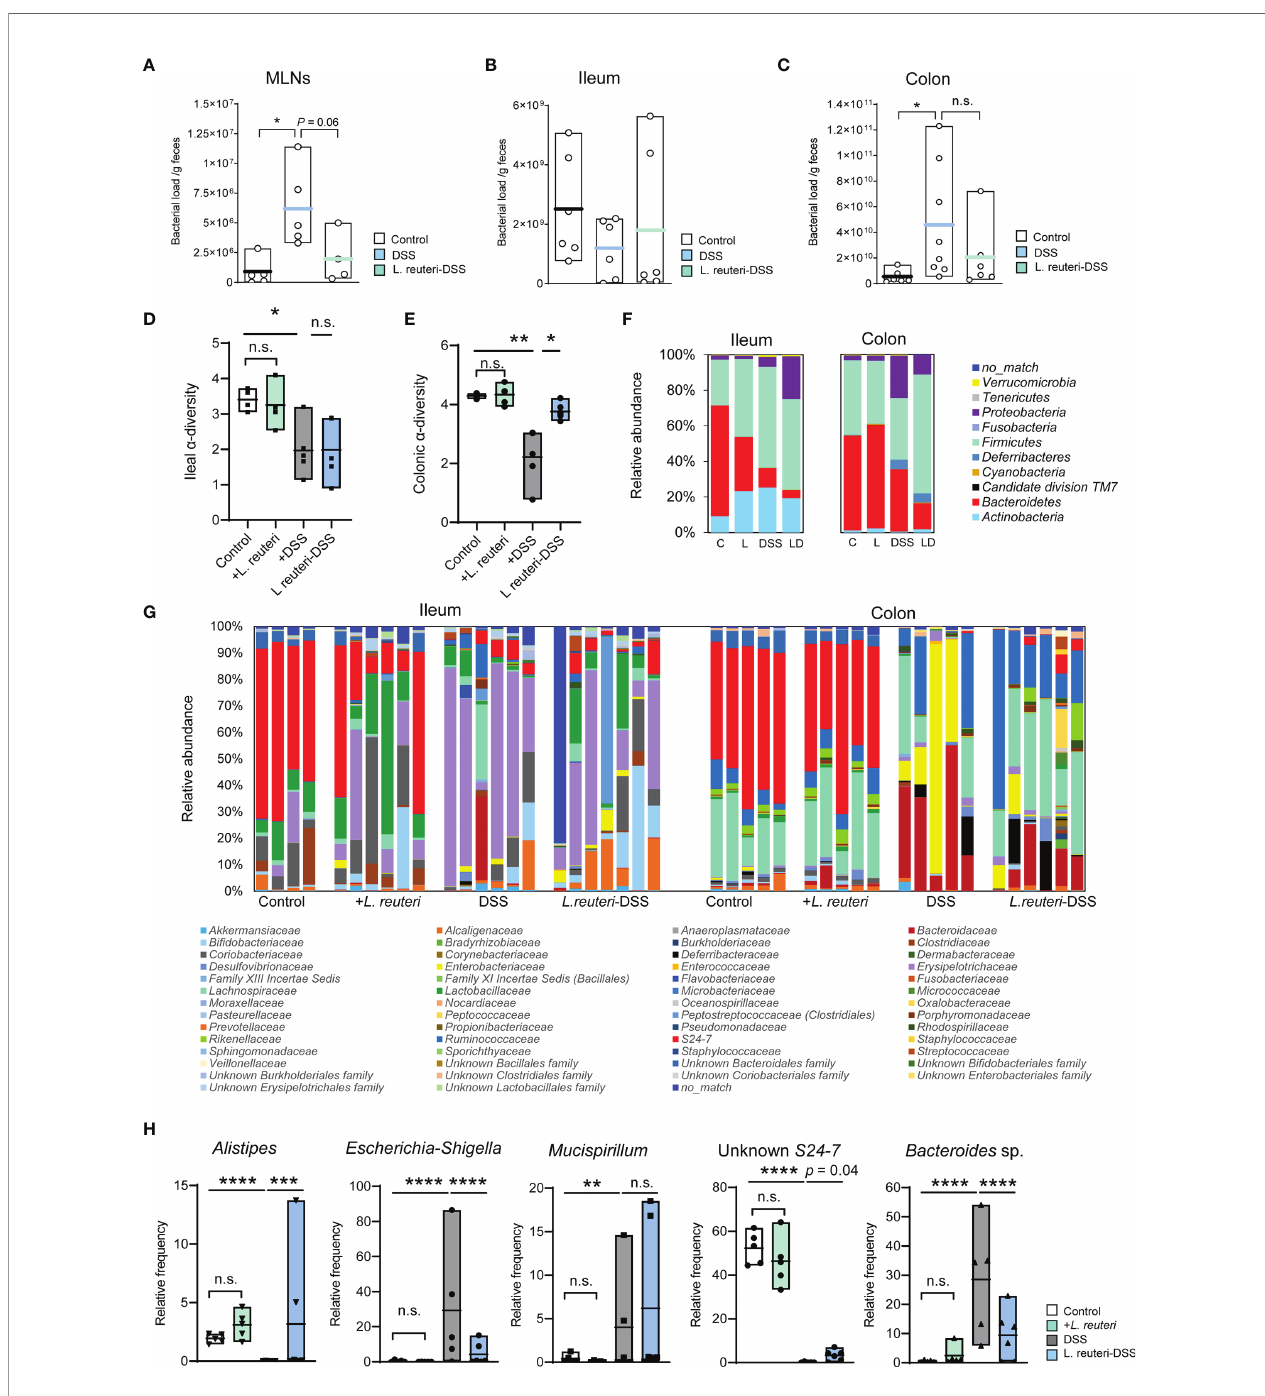
FIGURE 3 | Peroral treatment with L. reuteri reduces gut microbiota dysbiosis in DSS-induced colitis in young mice. (A – C) Microbial loads in MLNs and ileal and colonic luminal contents were quanti fi ed by q-RT-PCR on the 16S rRNA gene (normalized to sample weight). (D, E) Ileal and colonic microbiomes were assessed by 16S rRNA gene amplicon sequencing. The a -diversity of microbial community was calculated. (F, G) Taxonomic distributions of bacterial composition in the ileum and colon at phylum and family levels. (H) Relative abundance of Alistipes , Escherichia-Shigella , Mucispirillum , Unknown S24-7 , and Bacteroides sp. in the colonic microbiota (n = 4 – 6 mice per group). C, control; L, L. reuteri ; D, LD, L. reuteri -DSS. Data are mean ± SEM. * p < 0.05, ** p < 0.01, *** p < 0.001, and **** p < 0.0001 ( p -values were adjusted with false discovery rate control using the method of Benjamini and Hochberg). DSS, dextran sulfate sodium, MLNs, mesenteric lymph nodes. ns, non signi fi